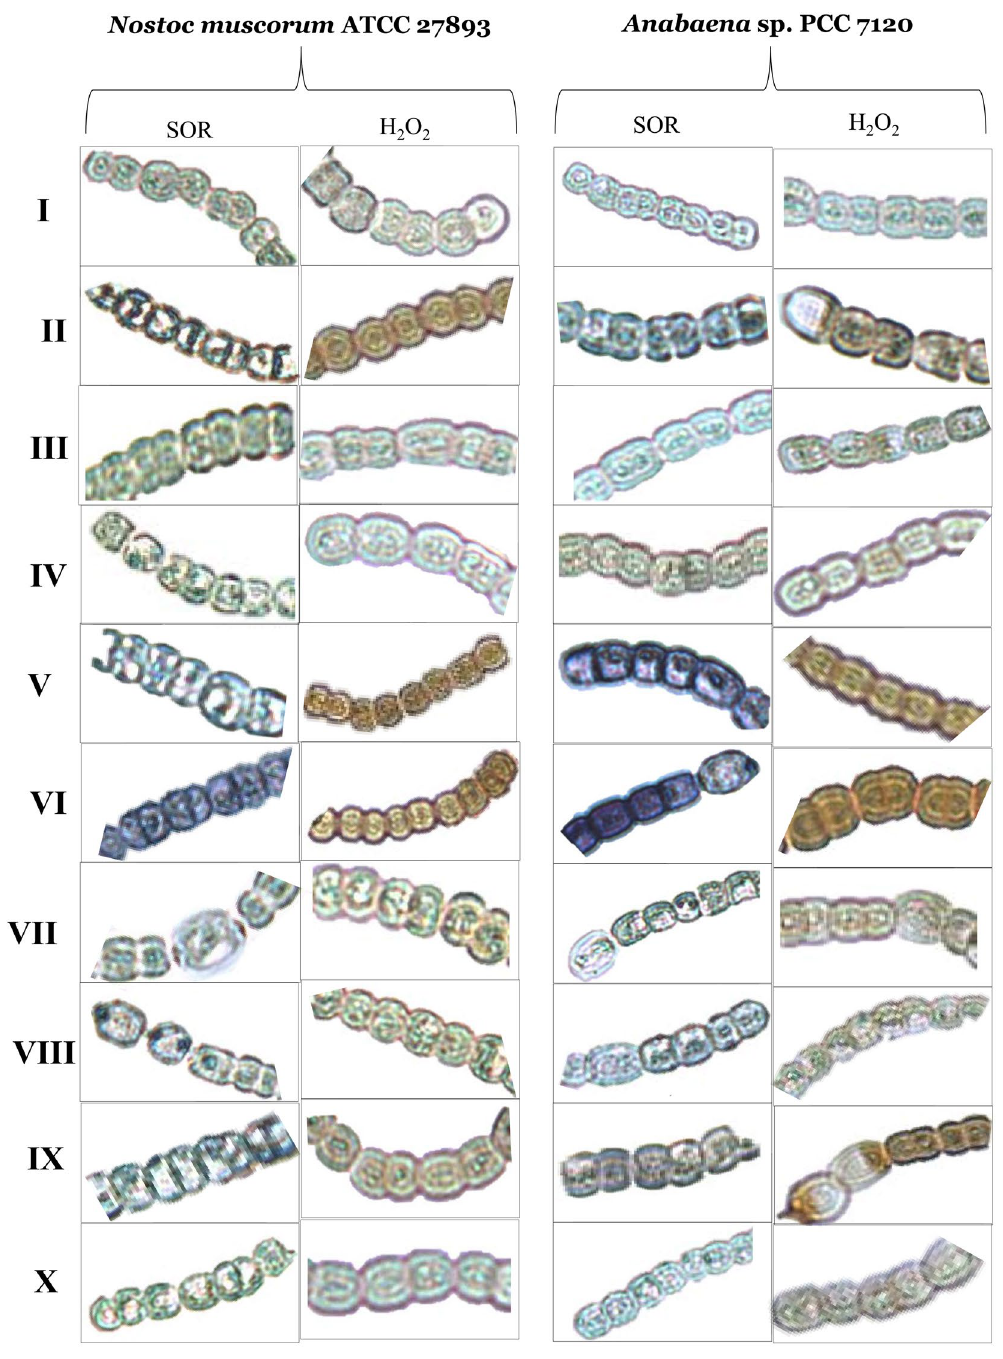
Figure 3. In vivo visualization of SOR; blue staining and H 2 O 2 accumulation; brown staining inside the cells of Cd stressed Nostoc muscorum ATCC 27893 and Anabaena sp. PCC 7120 when treated with H 2 O 2 and NO (SNP). Where lane I: Control, lane II: Cd, lane III: Cd + H 2 O 2 , lane IV: Cd + SNP, lane V: Cd +